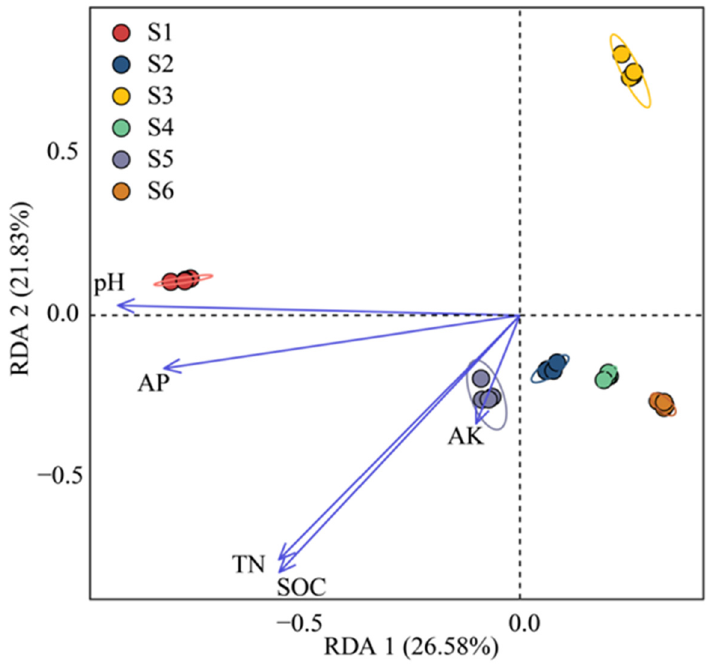
Figure 8. Redundancy analysis (RDA) relating environmental variables with cyanobacteria diver- sity.